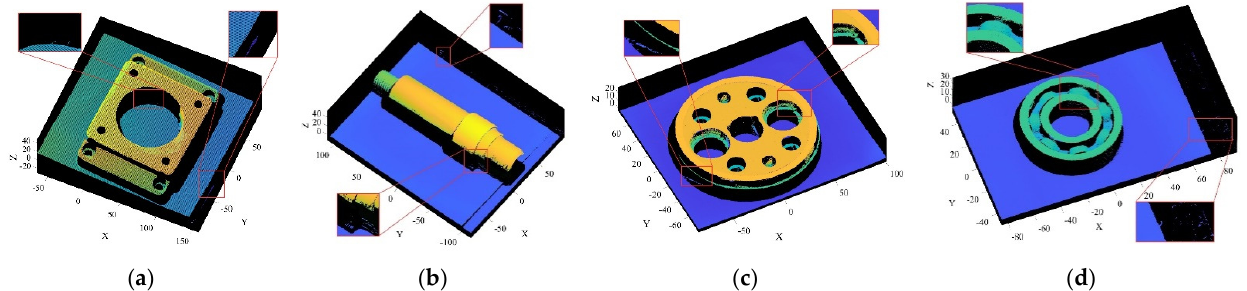
Sensors 2 22 , x FOR PEER REVIEW